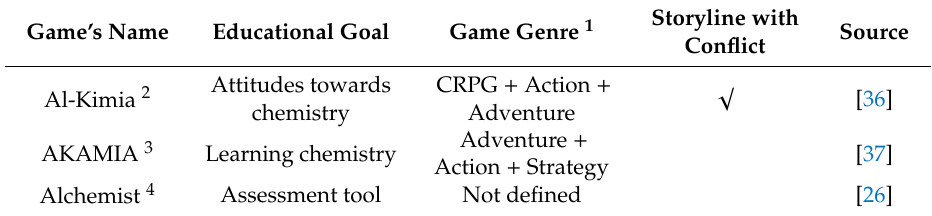
Table 1. Examples of single player games in the physical